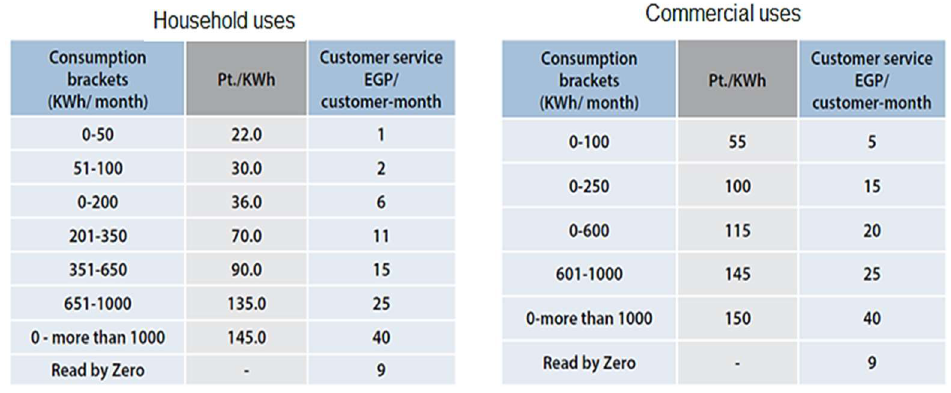
Figure 6. The average person consumed energy/year, kWh [72].